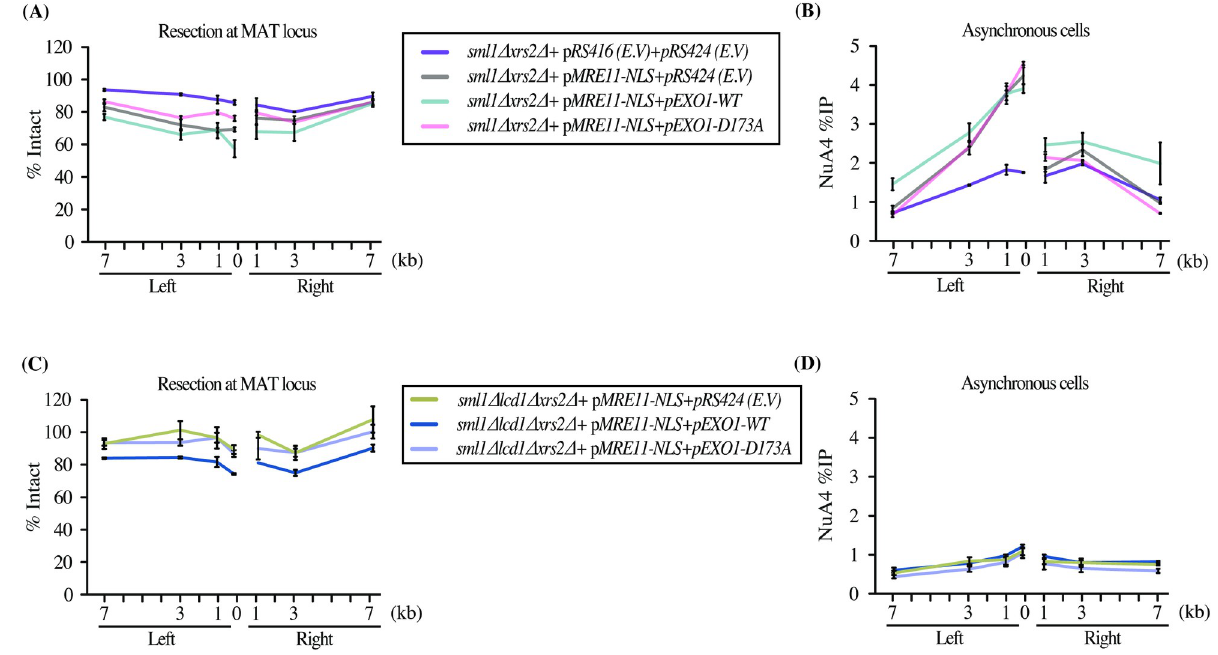
Fig 4. The alternate mode of NuA4 recruitment at the DSB is Lcd1/Ddc2-dependent. (A-B) Resection and NuA4 recruitment can be further rescued in the xrs2 Δ background by expressing Mre11-NLS along catalytically active Exo1. End resection is directly measured by decreased DNA signal near the break and NuA4 recruitment is monitored as before. Expression of a catalytically dead Exo1 is used as control (Exo1-D173A). (C-D) Resection is also rescued in the lcd1 Δ xrs2 Δ background with pMRE11-NLS and overexpression of Exo1-WT but not Exo1-D173A mutant, but this is not the case for NuA4 recruitment. NuA4 signal does not show a resection-correlated increase with Exo1-WT compared to the Exo1-D173A mutant or the empty vector. Resection is presented as % of Intact DNA determined by qPCR on genomic DNA at indicated sites and normalized to the negative control intergenic V. Cells were grown in YP-Raff till early log phase followed by addition of galactose for 3 hours to induce the DSB. Yeast strains used had similar HO cutting efficiency (S4C and S4D Fig).